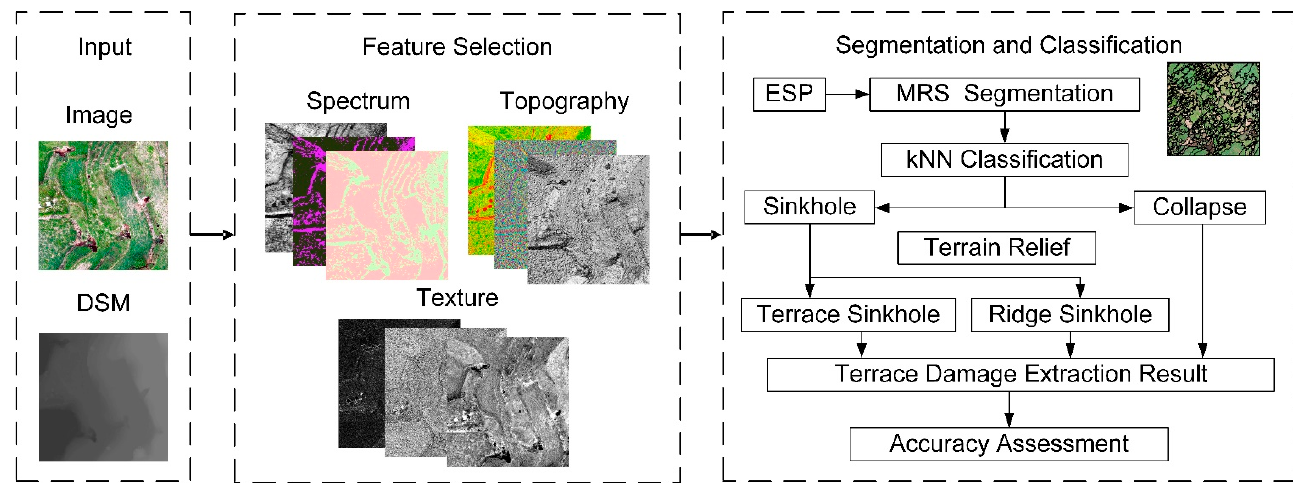
Figure 3. Workflow of the proposed extraction method.